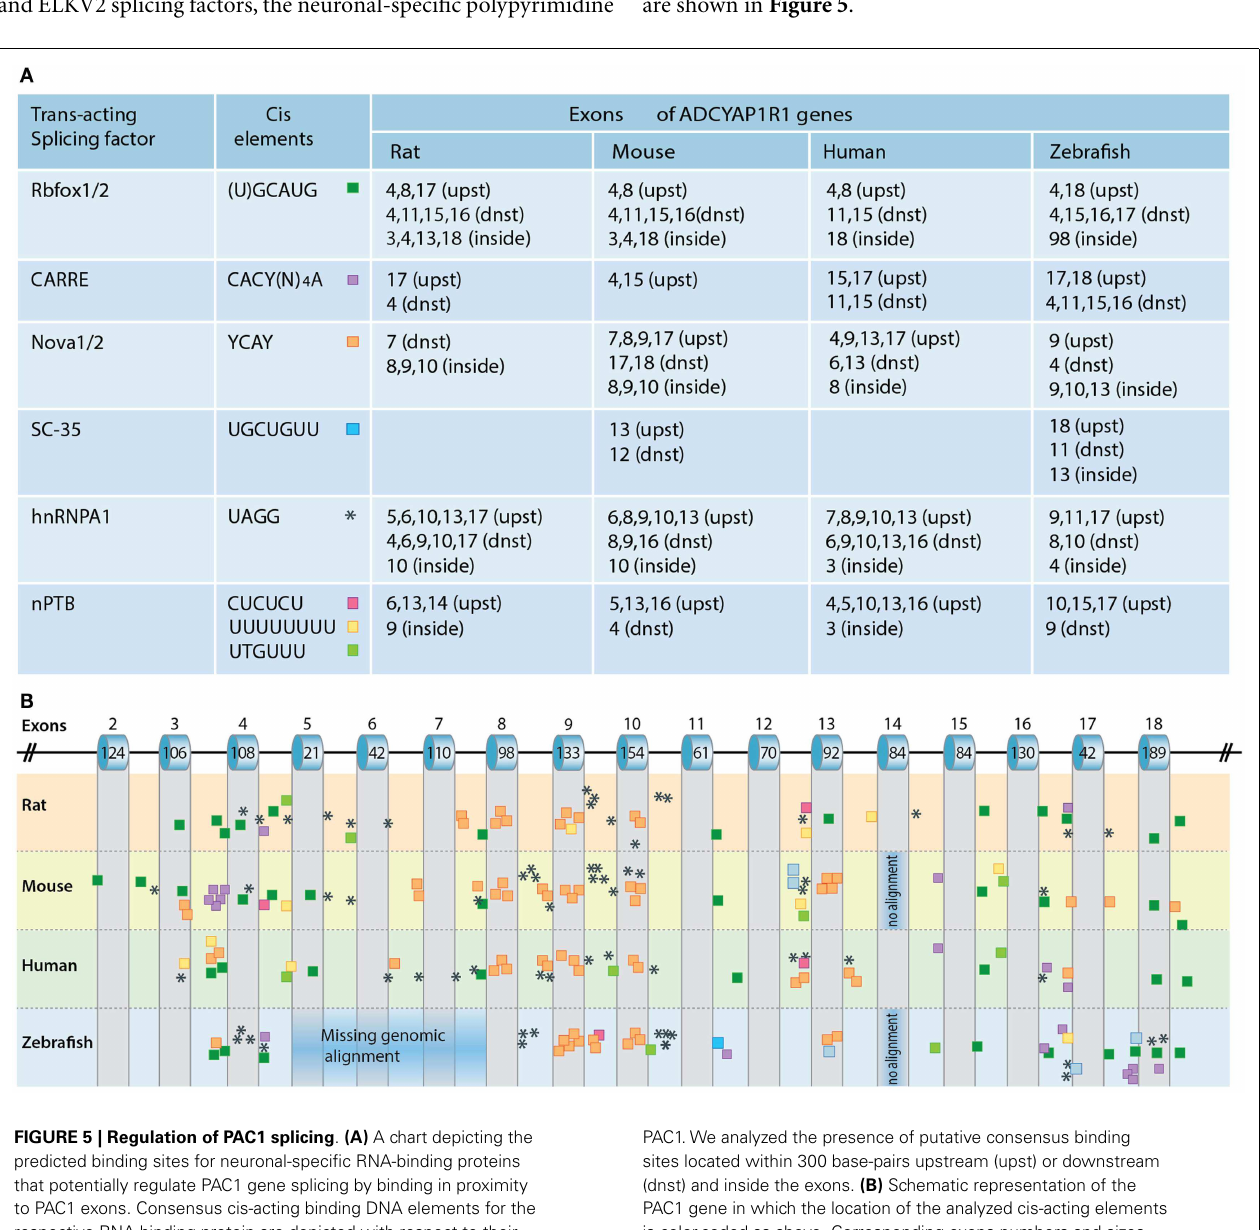
FIGURE 5 | Regulation of PAC1 splicing . (A) A chart depicting the predicted binding sites for neuronal-specific RNA-binding proteins that potentially regulate PAC1 gene splicing by binding in proximity to PAC1 exons. Consensus cis-acting binding DNA elements for the respective RNA-binding protein are depicted with respect to their position in the PAC1 genes of rat, mouse, human, and zebrafish